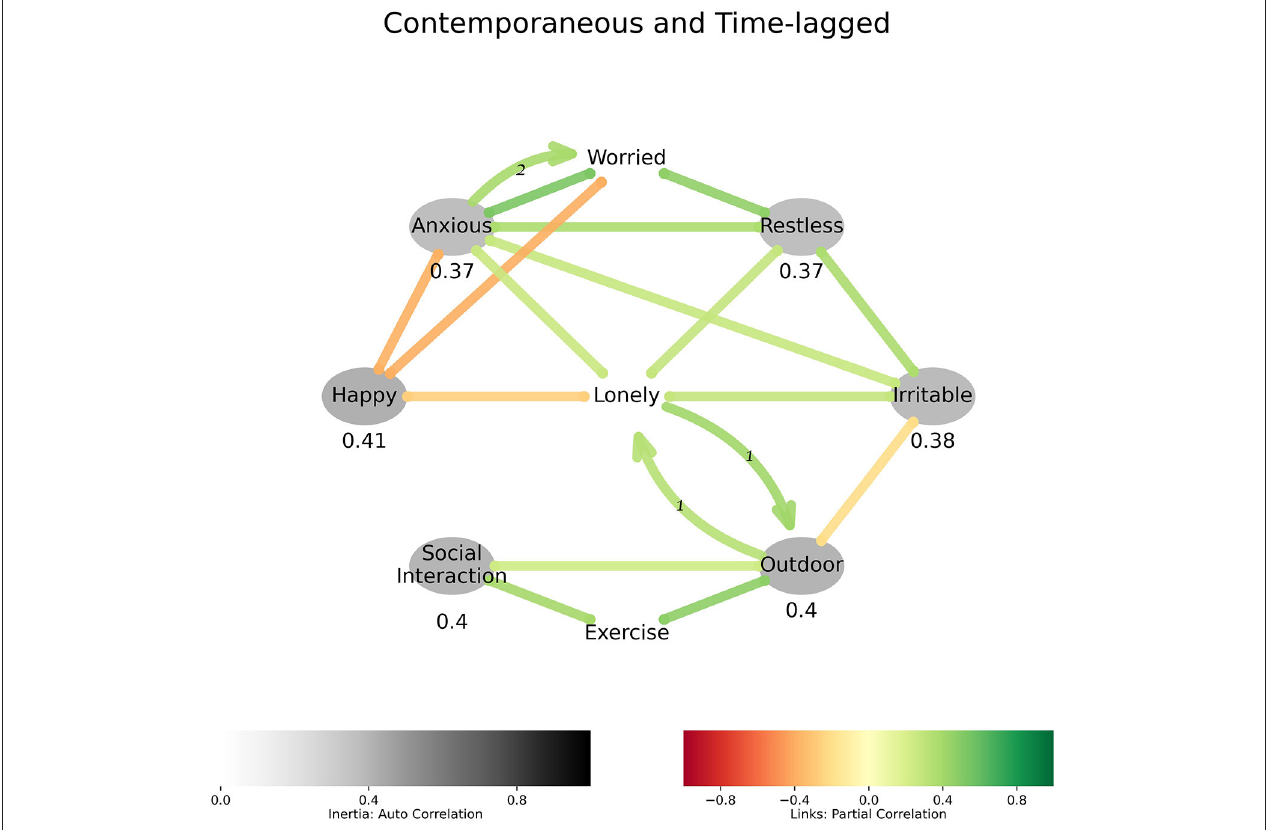
FIGURE 3 | Affect, loneliness, and behavior: Loneliness is predictive of being outdoors. Loneliness is not contemporaneous to being outdoors, it precedes it and returns soon